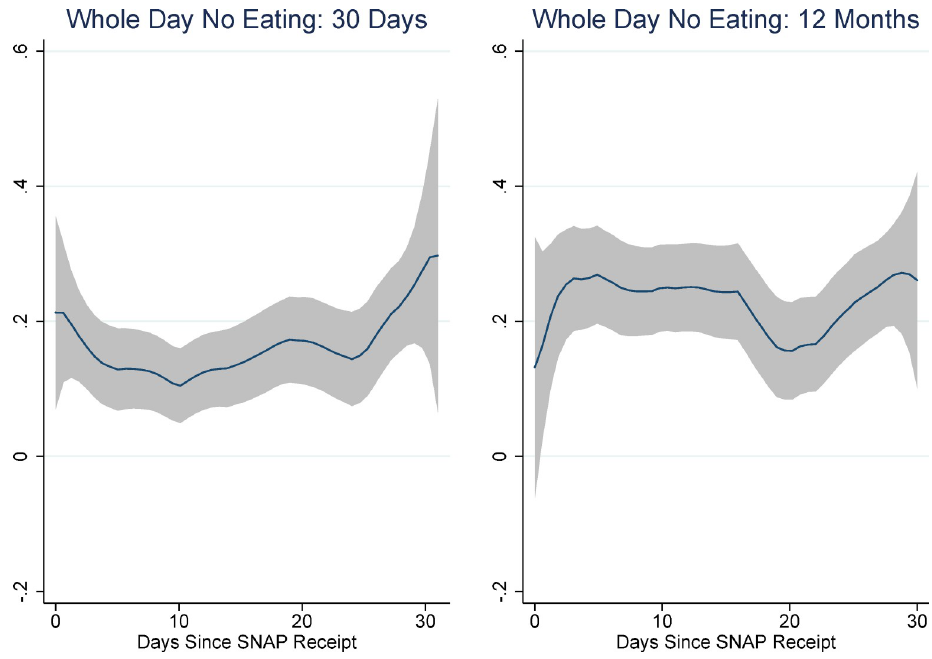
Fig 8. Individual 30-day and household 12-month responses to not eat for a whole day FSM item and days since SNAP. Source: Authors’ calculations using NHANES data. N = 618. Non-parametric regression estimates are